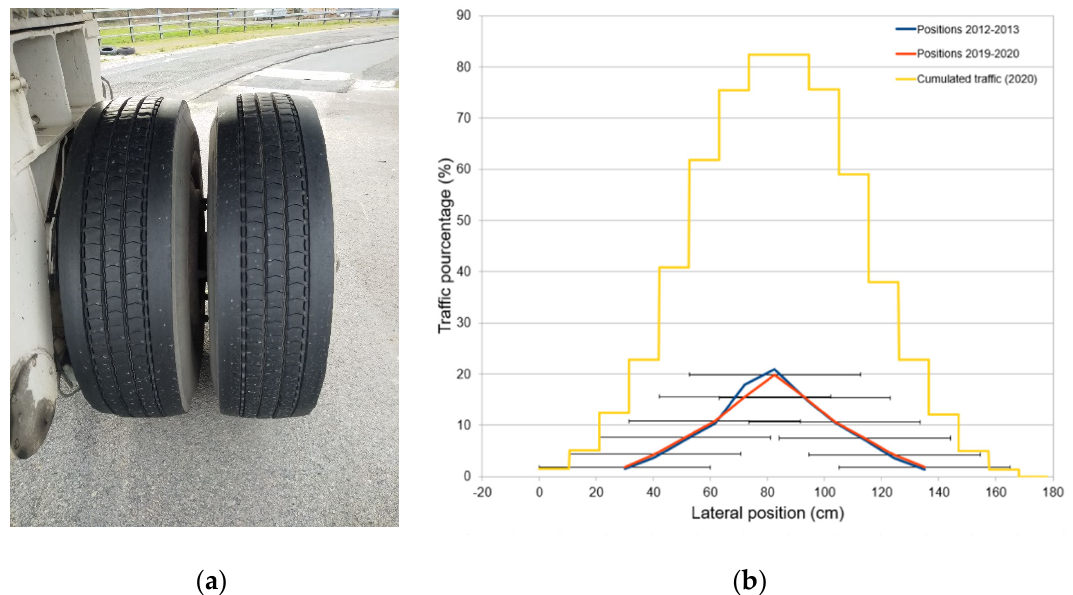
Figure 2. ( a ) Dual wheels of the carrousel, ( b ) Traffic density vs. lateral positions of the dual wheels per 100 K loadings.